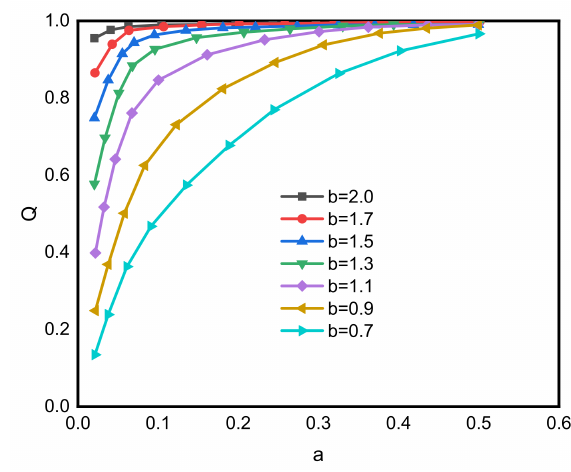
Figure 4. The relationship diagram of a, b, and Q 1 .